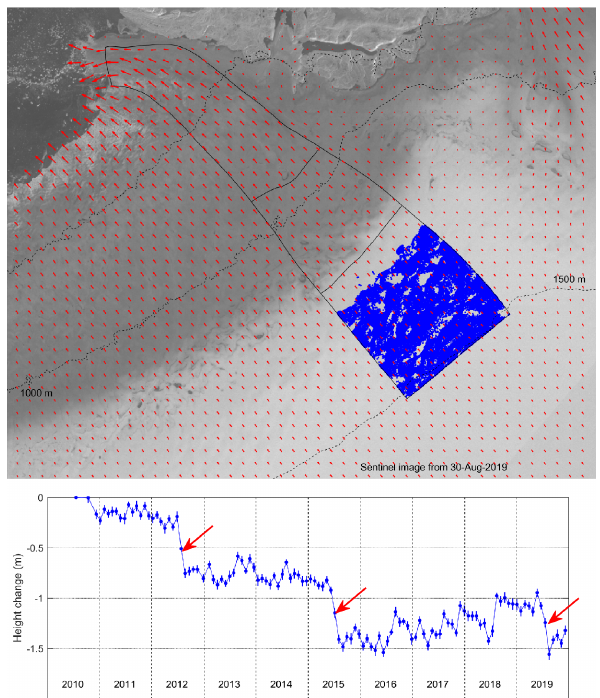
Figure 3. (a) Part of the 30 August 2019 Sentinel SAR image show- ing the positions (blue dots) of the 44756 CryoSat POCA height estimates which were used in deriving the average 30d temporal height change plot shown in (b) . The short vertical lines at each point are ± 2 times the standard error of the mean of the height change estimates for each point and are an indication of the ran- dom error in the results. The three red arrows highlight the anoma- lous average summer height loss in 2012, 2015, and 2019 that has been ascribed to firn compaction due to warm temperatures at these elevations in these